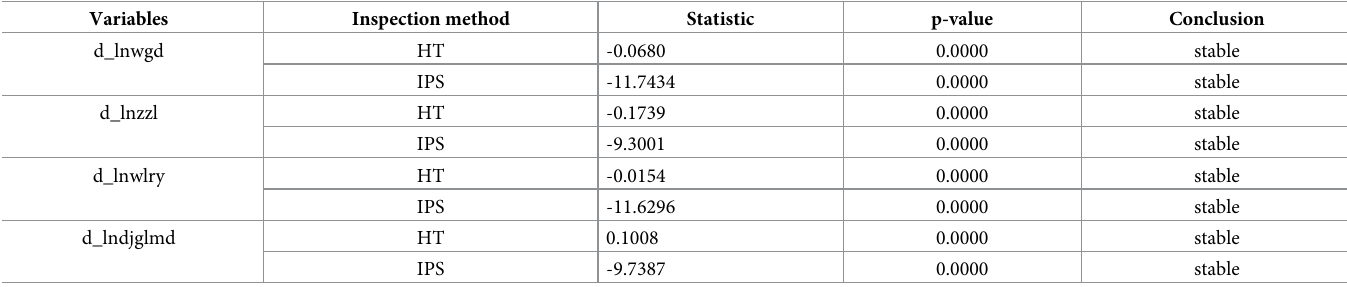
Table 19. Description of unit root test results of variable first-order difference